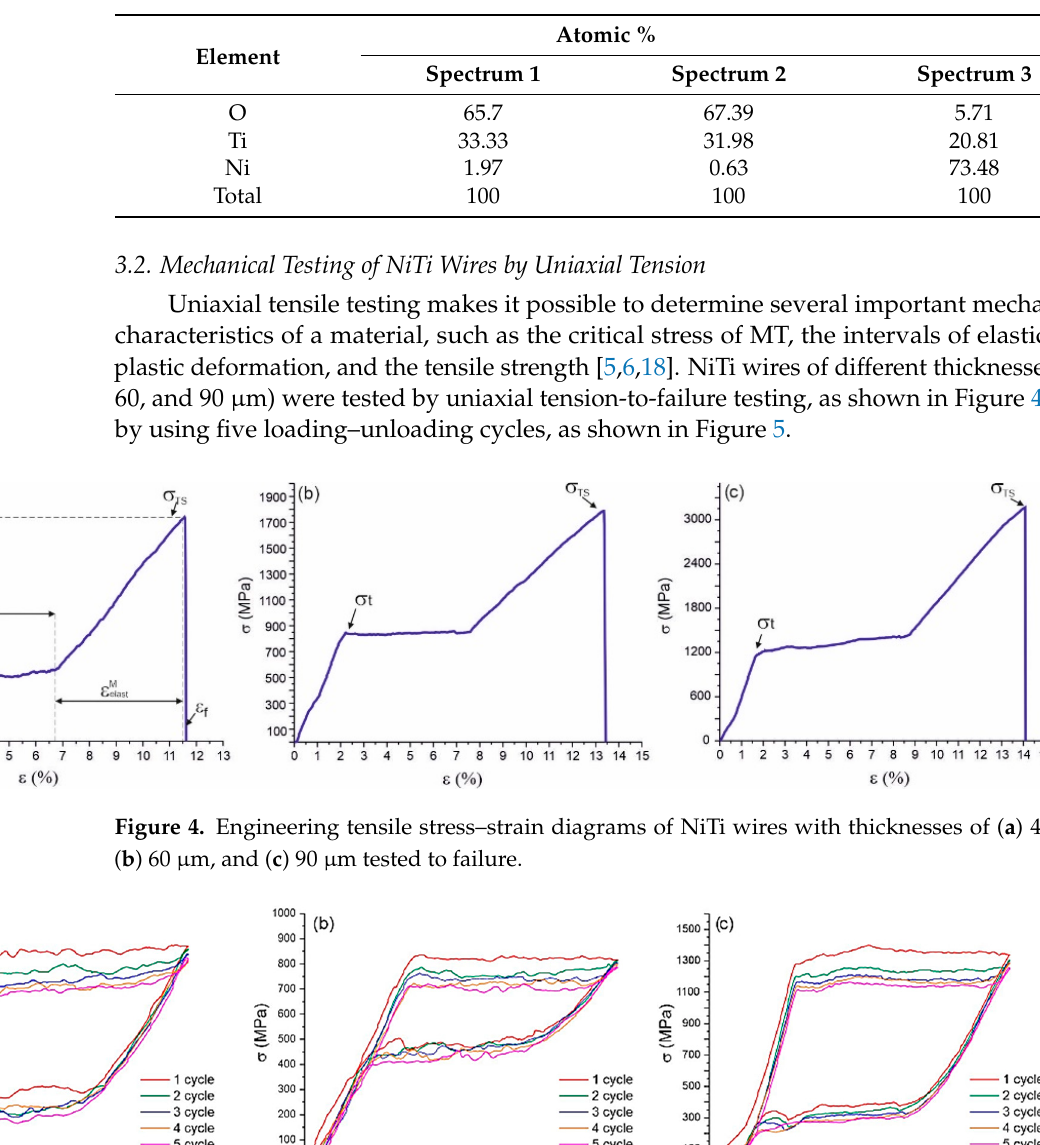
Table 1. Results of elemental analysis in the surface layer of the 60 µ m thick NiTi wire.